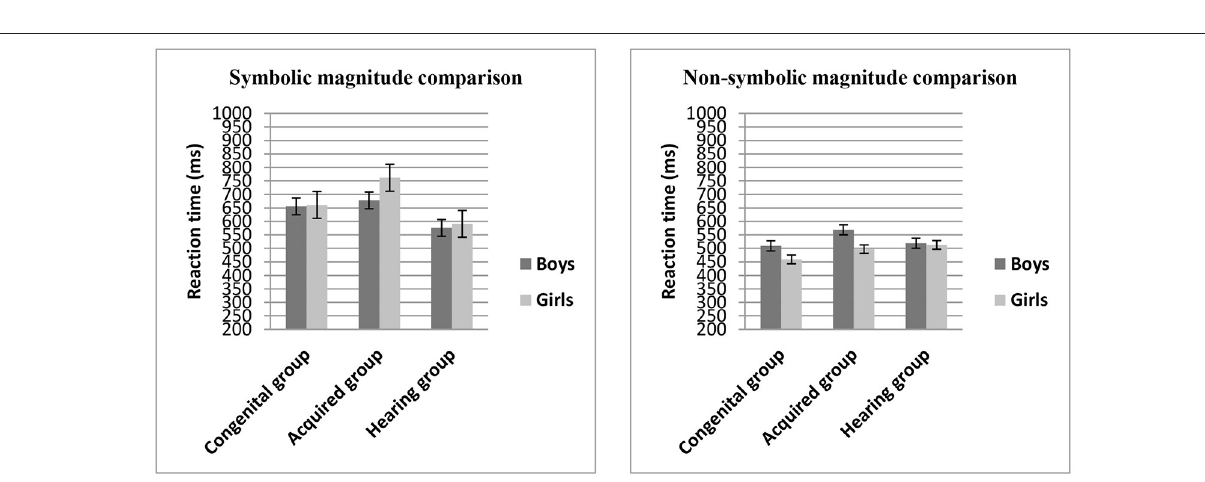
Frontiers in Psychology |